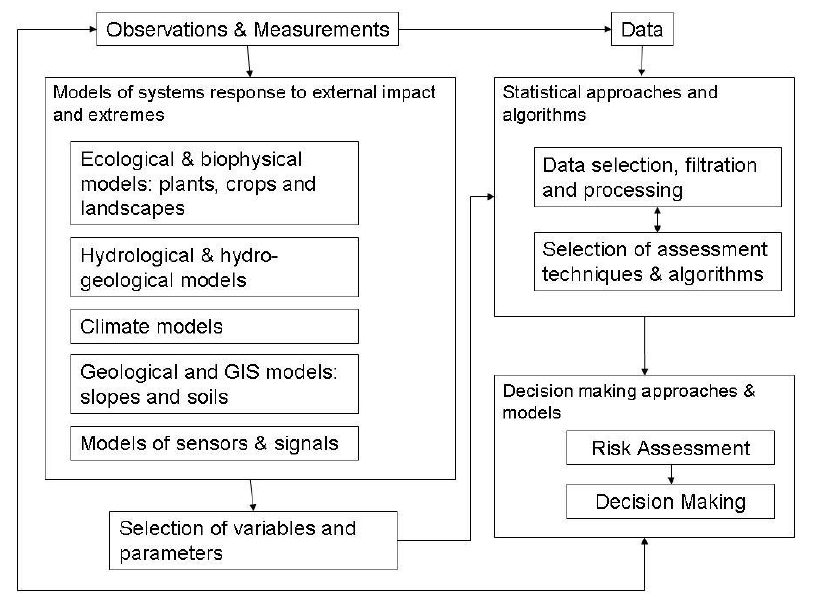
Fig. 2. Data utilization in framework of multi-modeling approach for socio-ecological risks assessment